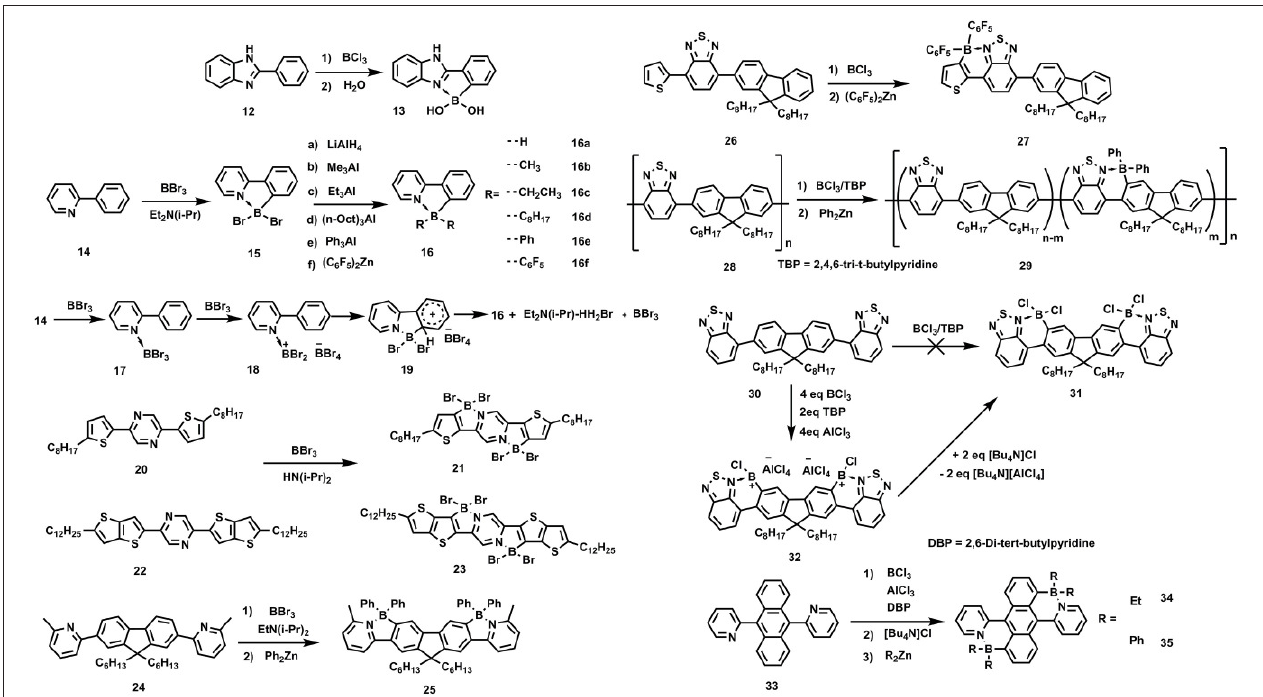
FIGURE 4 | Examples of synthesis routes toward B ← N embedded units involving BX 3 / hindered base reaction system.